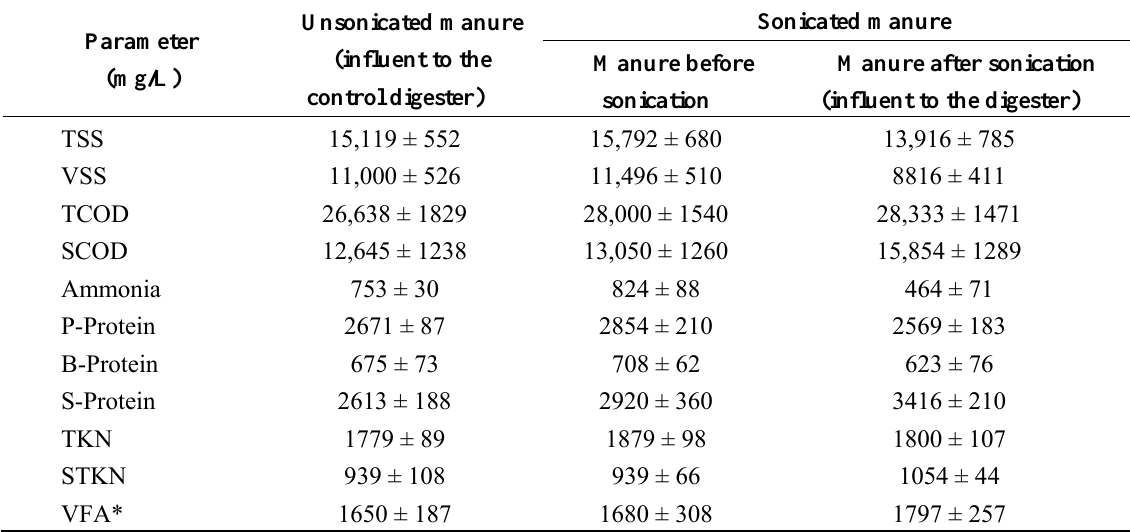
Table 1. Feed characteristics used for the unsonicated and sonicated